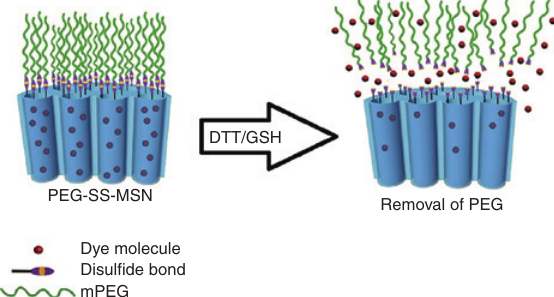
Figure 2: Redox-responsive MSN: disulfide bonds are broken at a high concentration of GSH, and the caps (here PEG molecules) are removed, and the loaded dye is released. Reused from Reference [41] with the permission of Elsevier